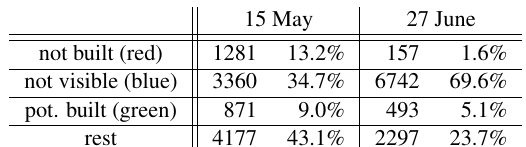
Table 2. Numerical results for the visibility checks: the number of triangles for each class are given For all triangles labeled as potentially built the verification rate is calculated and the label is changed to built if it is higher then 50%. In Figure 10 the results for both time steps is depicted. All triangles labeled as potentially built in one of the both data sets (i.e., all green triangles from Figure 8 and 9) are shown, the colored triangles are the one which are verified. The green tri- angles indicate the elements confirmed by the point cloud